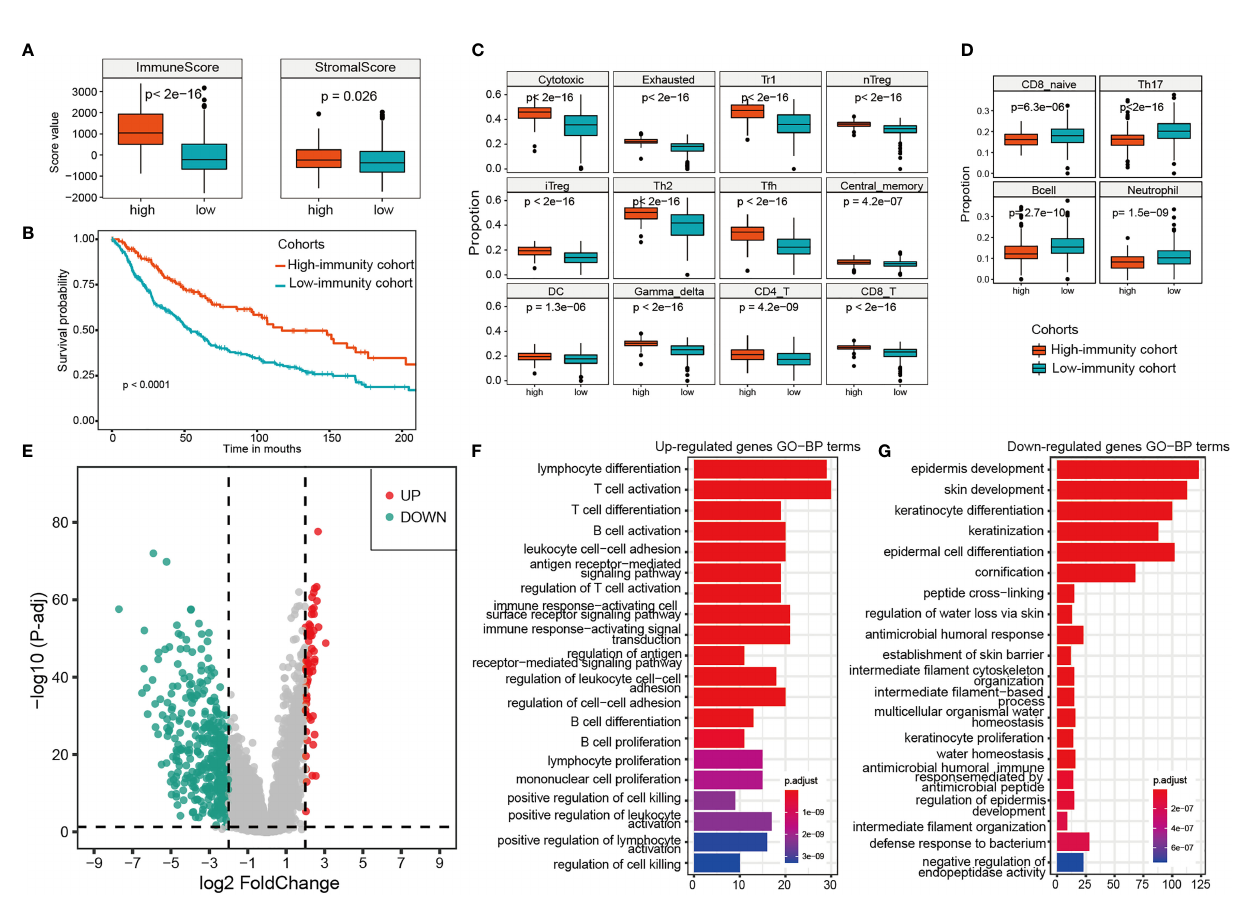
FIGURE 2 | Differences of the immune cells population, expression analysis and functional enrichments between the high-immunity and the low-immunity cohort. (A) The immune score and stromal score of the high-immunity and the low-immunity cohort. (B) Kaplan-meier curves of overall survival for the two immunity cohorts. Log rank test, p <0.0001. (C) 16 signi fi cantly higher immune cells in the high-immunity cohort. (D) 4 signi fi cantly higher immune cells in the low-immunity cohort. (E) Volcano Plot of the DEGs for the high-immunity cohort. (F, G) GO function enrichments analysis of up-regulated and down-regulated genes for the high-immunity